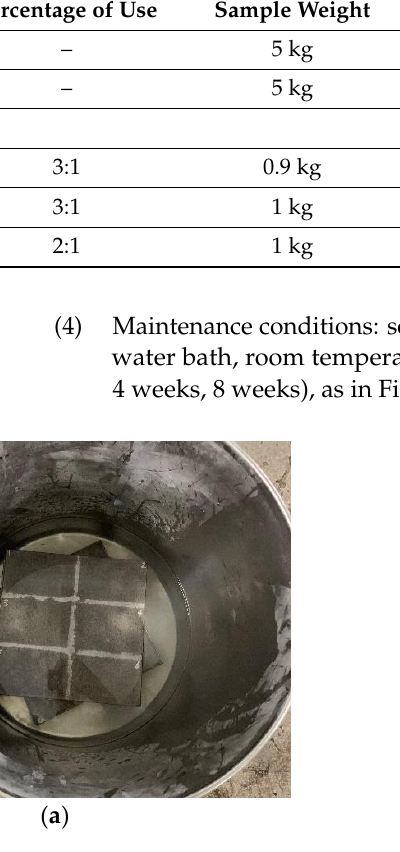
Table 5. Table of requirements for the use of epoxy resin components.